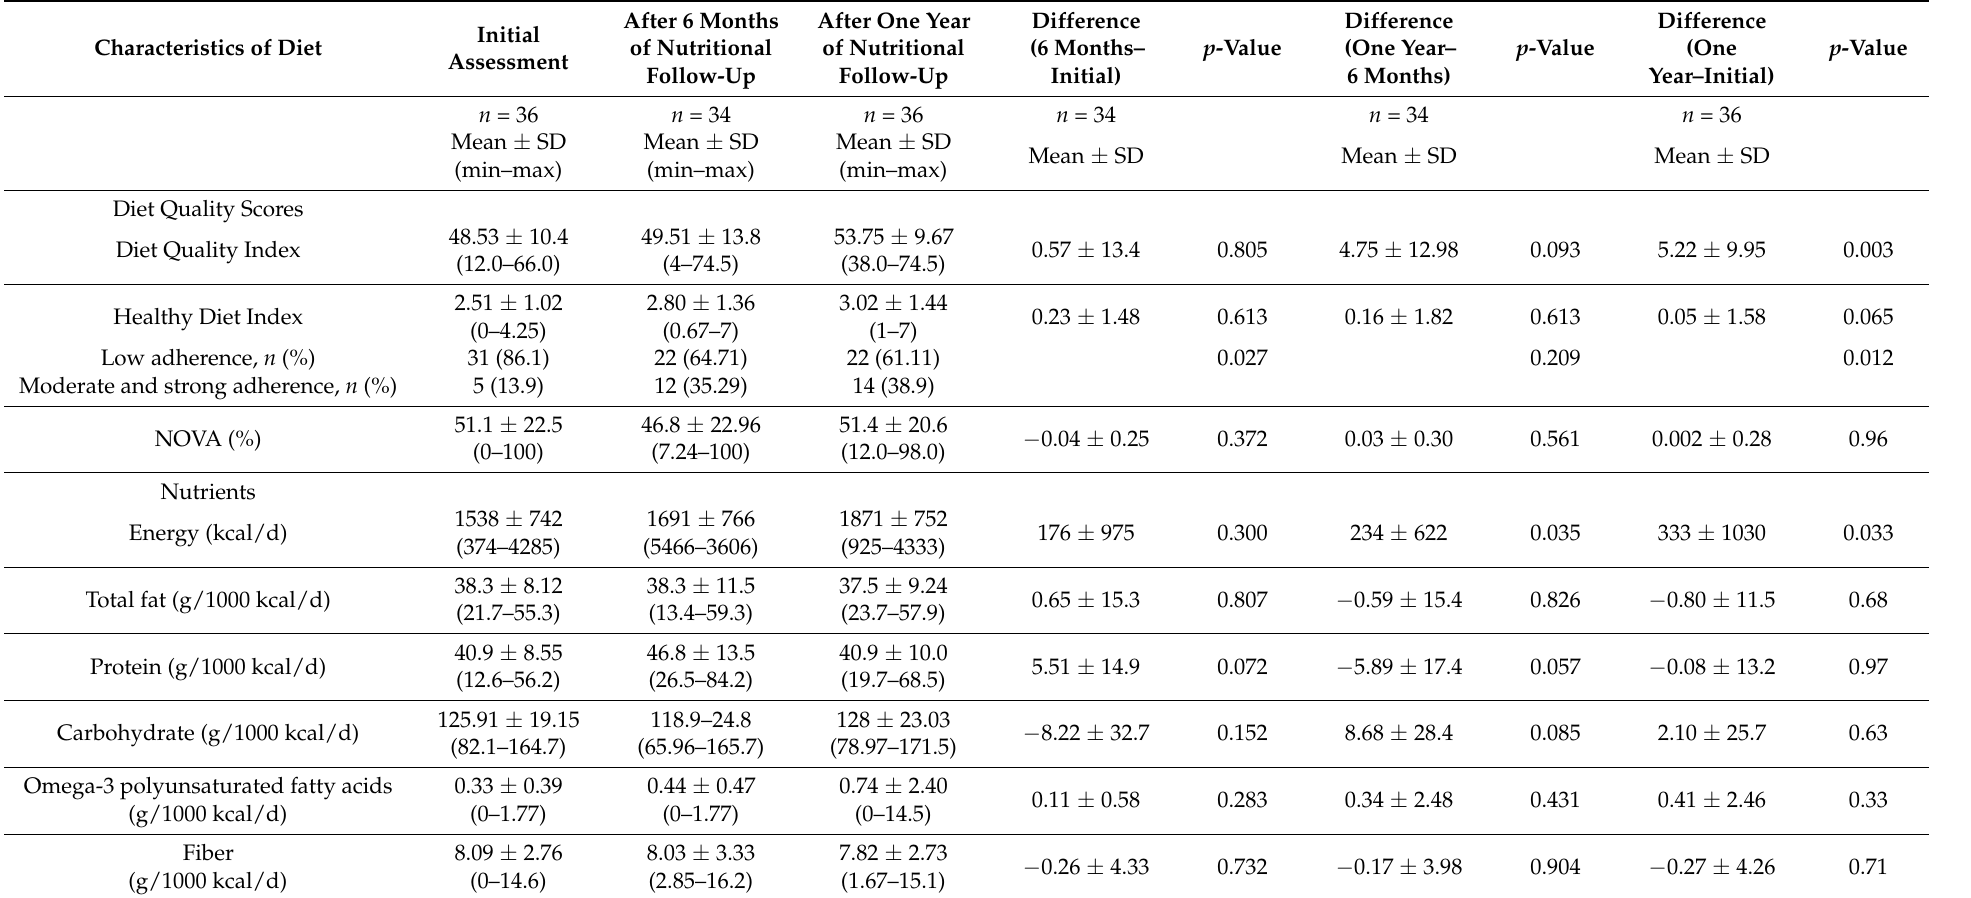
Table 2. Dietary intakes and scores of diet quality at the initial assessment, after 6 months, and one year of nutritional